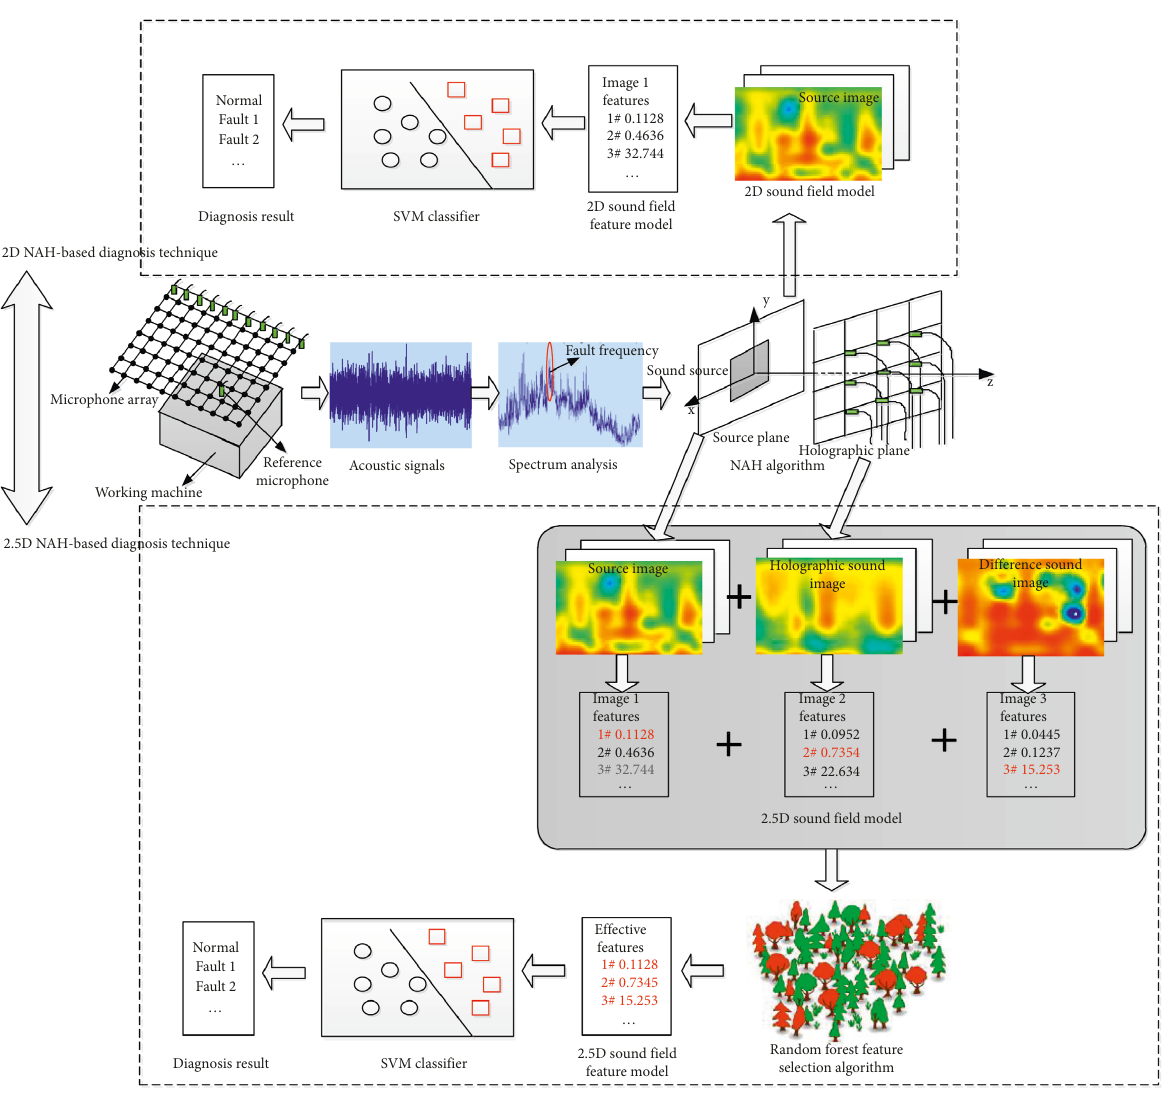
Figure 1: Flowchart of fault diagnosis based on 2D/2.5D sound